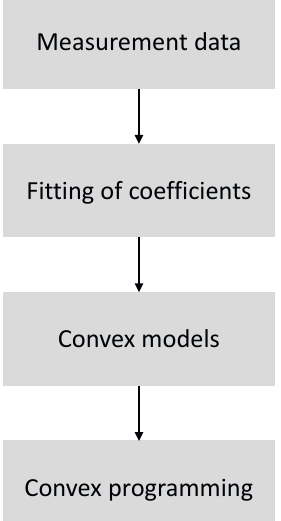
Figure 3. A data-driven approach to derive convex models. In order to apply convex programming, constraints and cost function are also required to be